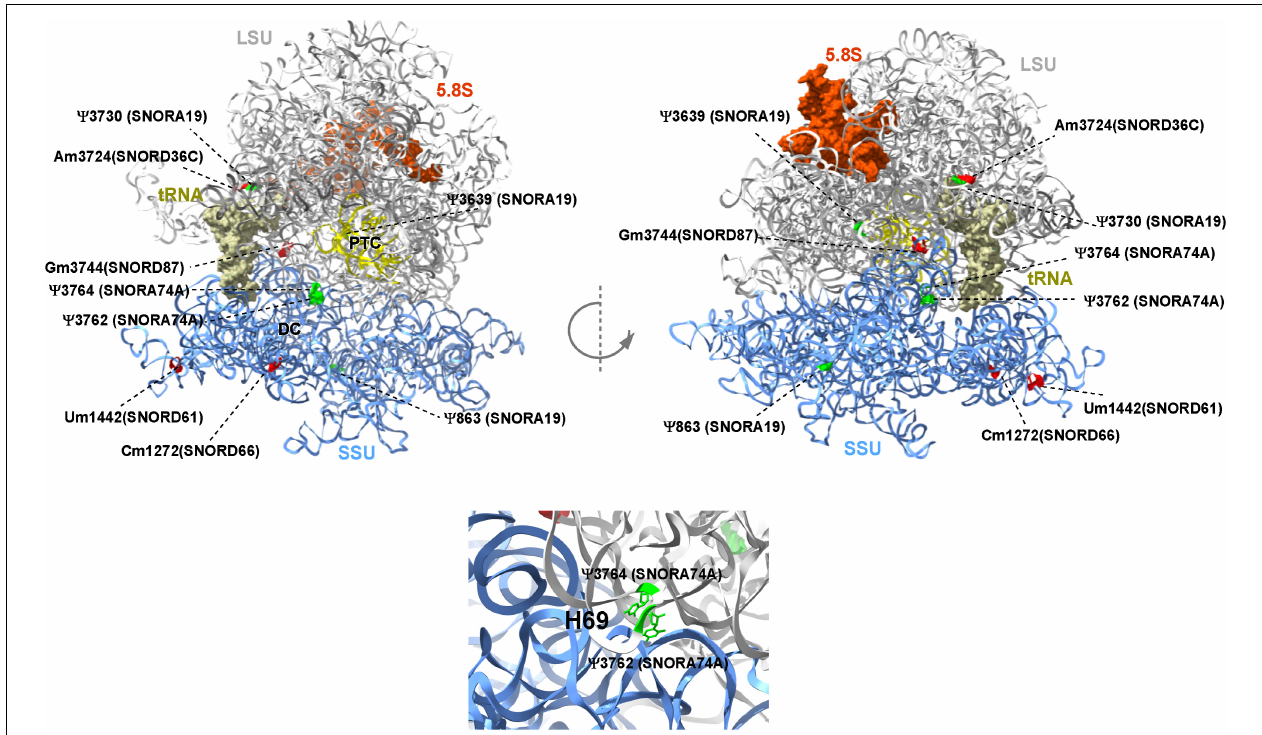
FIGURE 3 | Deregulated snoRNAs guide specific rRNA modifications on human ribosome. Nm sites are indicated in red and ψ sites are indicated in green, respectively. The identity of snoRNA guiding each modification is shown. The peptidyl transferase center (PTC), E site tRNA, decoding center (DC), and helix H69 are indicated. The large subunit (LSU), small subunit (SSU), and 5.8S rRNA are colored in gray, blue, and brown, respectively. The 3D representation is based on the published CryoEM structure of the human 80S ribosome (PDB 6EK0)